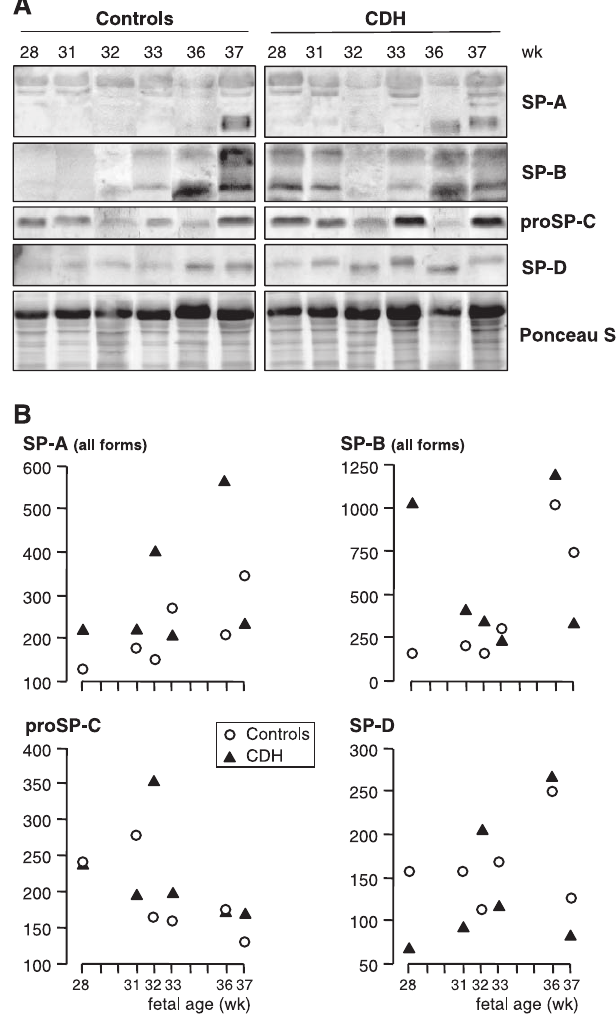
Figure 2. SPs in Human Fetal Lungs (A) Western blots: Samples were electrophoresed by SDS-PAGE, trans- ferred, and successively incubated with specific anti-SP antibodies. (B) Densitometric analysis normalized by Ponceau S for gel loading (arbitrary units). SPs were detected at all stages. SP-A monomers were extremely faint before 36 wk, when they increased sharply (A) resulting in an increase in total amount (B). SP-B also increased markedly at 36–37 wk, ProSP-C did not display developmental changes, and SP-D showed a weak increase (A, B). There were no obvious differences between CDH and control lungs for any SP, with developmental changes occurring at the same fetal ages, the only exception being presentation of a high SP-B level in one CDH fetus, aged 28 wk.